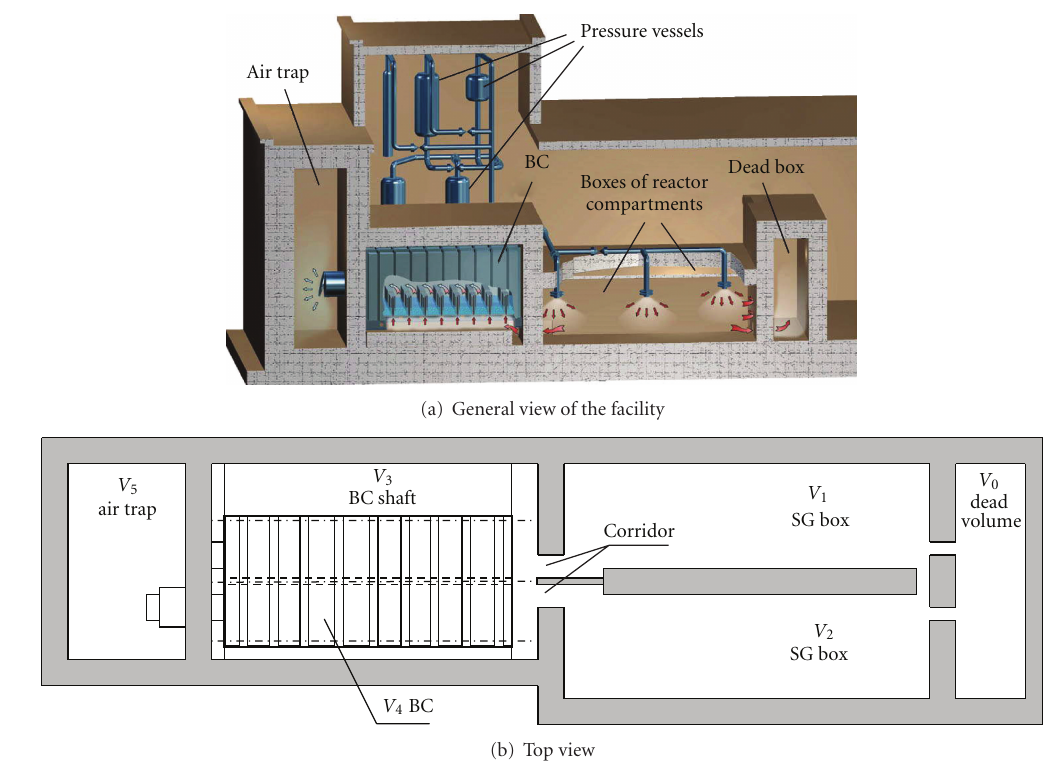
Figure 2: BC V-213 test facility.